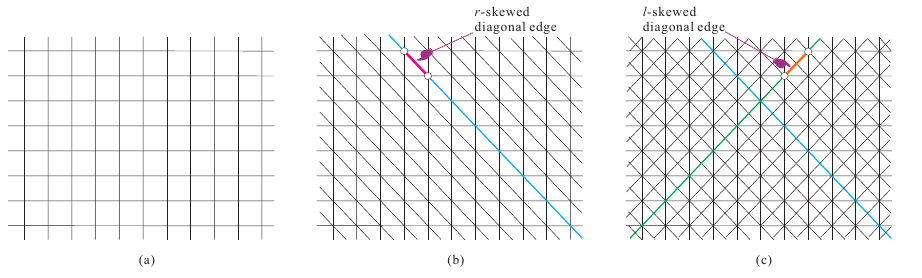
Figure 1. Partial fragments of ( a ) G ∞ , ( b ) T ∞ , and ( c ) S ∞ . ∞ An extended supergrid graph is a finite connected subgraph of S , while a grid graph (respectively, triangular grid graph , supergrid graph ) is a finite and vertex-induced subgraph ∞ ∞ ∞ of G (respectively, T , S ). Note that an extended supergrid graph is not necessarily a ∞ vertex-induced subgraph of S . Thus, extended supergrid graphs contain grid graphs, triangular grid graphs, and supergrid graphs as subclasses of graphs. A diagonal supergrid graph is an extended supergrid graph with an edge set that contains at least one l -skewed and one r -skewed diagonal edge, and a triangular supergrid graph is an extended supergrid graph such that its edge set contains at least one r -skewed diagonal edge and no l -skewed diagonal edges. In general, a diagonal supergrid graph is not necessarily a supergrid graph, and vice versa. The same applies to triangular supergrid graphs and triangular grid graphs. Let C e , C g , C s , C d , C τ , and C t be the graph classes of extended supergrid, grid, supergrid, diagonal supergrid, triangular supergrid, and triangular grid graphs, respectively. Then, C g , C s , C d , C τ , C t ⊂ C e , C g ∩ C s = C g ∩ C t = C s ∩ C t = ∅ , C s ∩ C d (cid:54) = ∅ , and C τ ∩ C t (cid:54) = ∅ . Figure 2 shows the relationship among these graph classes and indi- cates the complexities of the studied problems for these graph classes. Obviously, all grid graphs are bipartite [33] and planar; however, (extended, diagonal, triangular) su- pergrid graphs and triangular grid graphs may not be bipartite. Let G g , G s , and G t be a grid, supergrid, and triangular grid graph, respectively. Let ν ∈ V ( G g ) , µ ∈ V ( G s ) ,